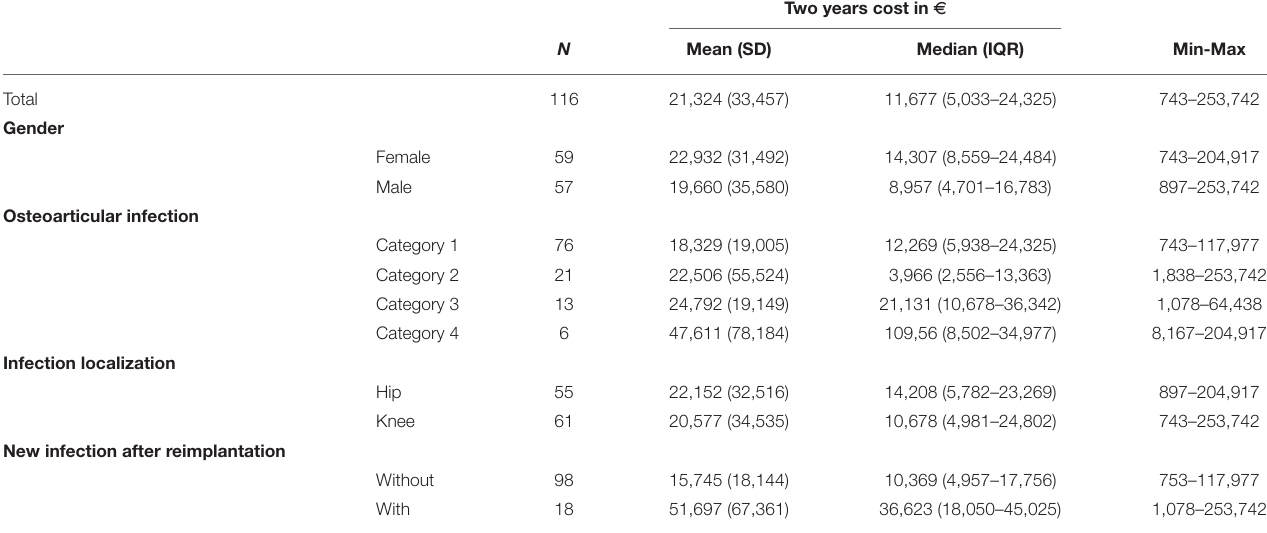
TABLE 3 | Subgroup analysis of costs.